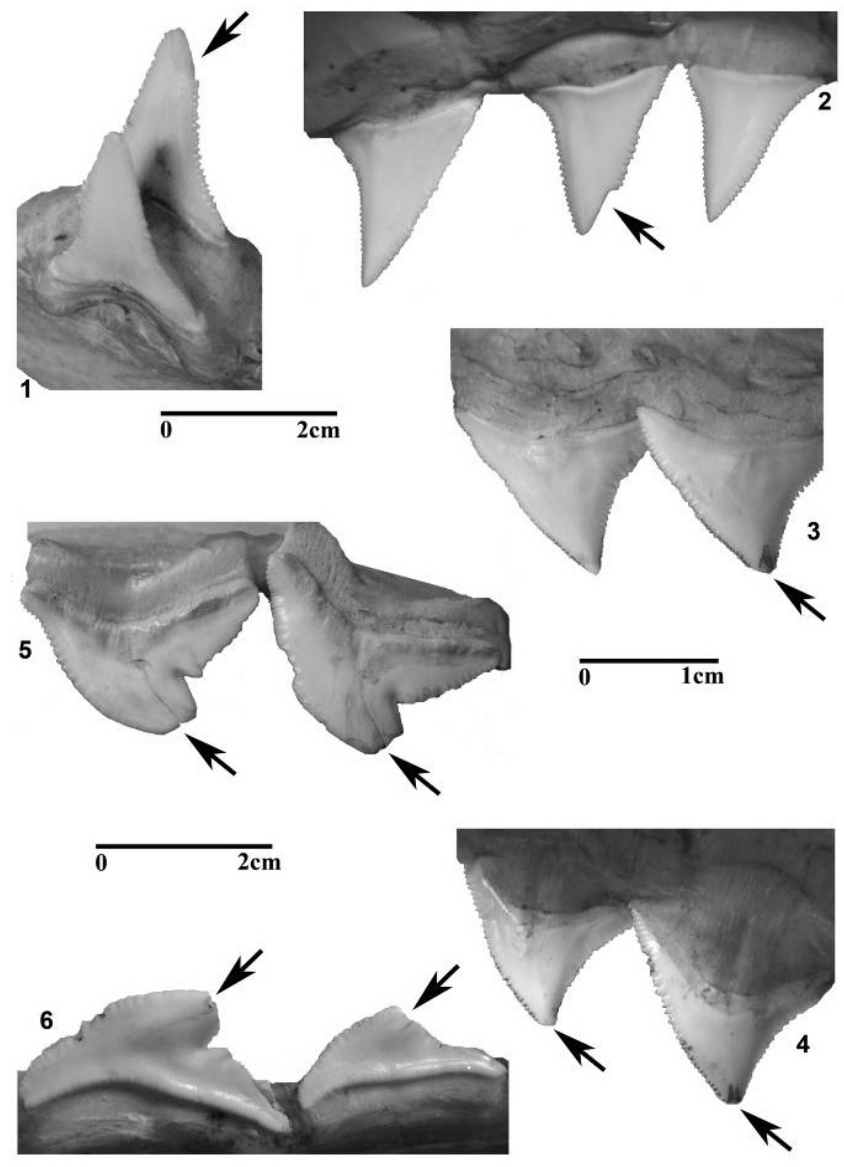
Figure 2. Modern shark jaws displaying functional teeth with feeding-related damage of the following types: (A) labial damage on the tooth cusp apex; (B) labial damage on the mesial or distal tooth edge; (C) lingual damage on the tooth cusp apex; and (D) lingual damage on the mesial or distal edge. 1 , labial view of an anterior tooth in the lower jaw of Carcharodon carcharias (AMNH 53095) with type A cusp damage; 2 , lingual view of a lateral tooth in the upper jaw of Carcharodon carcharias (AMNH 53095) with type D cusp damage; 3 , labial view of a lateral tooth in the upper jaw of Carcharhinus leucas (AMNH 225868D) with type A cusp damage; 4 , lingual view of a lateral tooth in the upper jaw of Carcharhinus leucas (AMNH 225868D) with type C cusp damage; 5 , labial view of a lateral tooth in the lower jaw of Galeocerdo cuvier (AMNH 37950SD) with type A and B cusp damage; 6 , labial view of a lateral tooth in the upper jaw of Galeocerdo cuvier (AMNH 37950SD) with type A and B cusp damage; Scale bars for 1,2,5,6 = 2.0 cm; 3,4 = 1.0